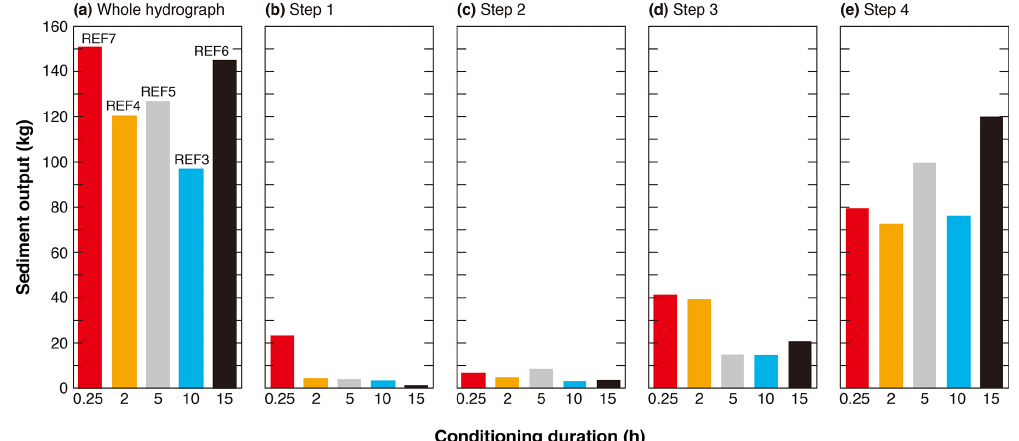
Figure 7. Sediment output measured at a trap during (a) the whole hydrograph, (b) step 1 of the hydrograph, (c) step 2 of the hydrograph, (d) step 3 of the hydrograph, and (e) step 4 of the hydrograph.